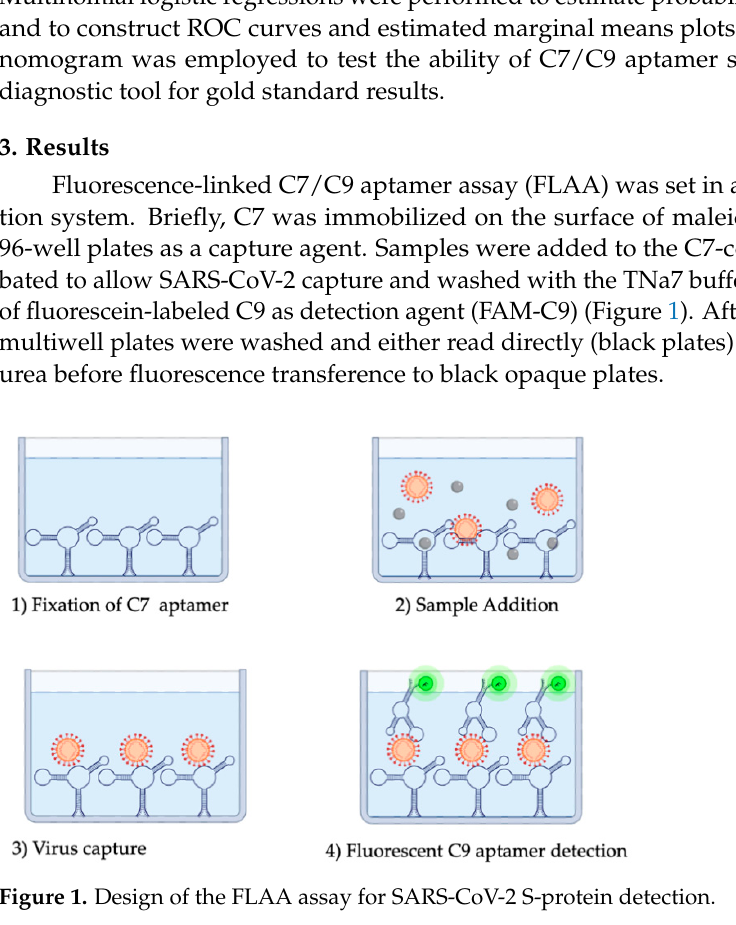
Figure 1. Design of the FLAA assay for SARS ‐ CoV ‐ 2 S ‐ protein detection.